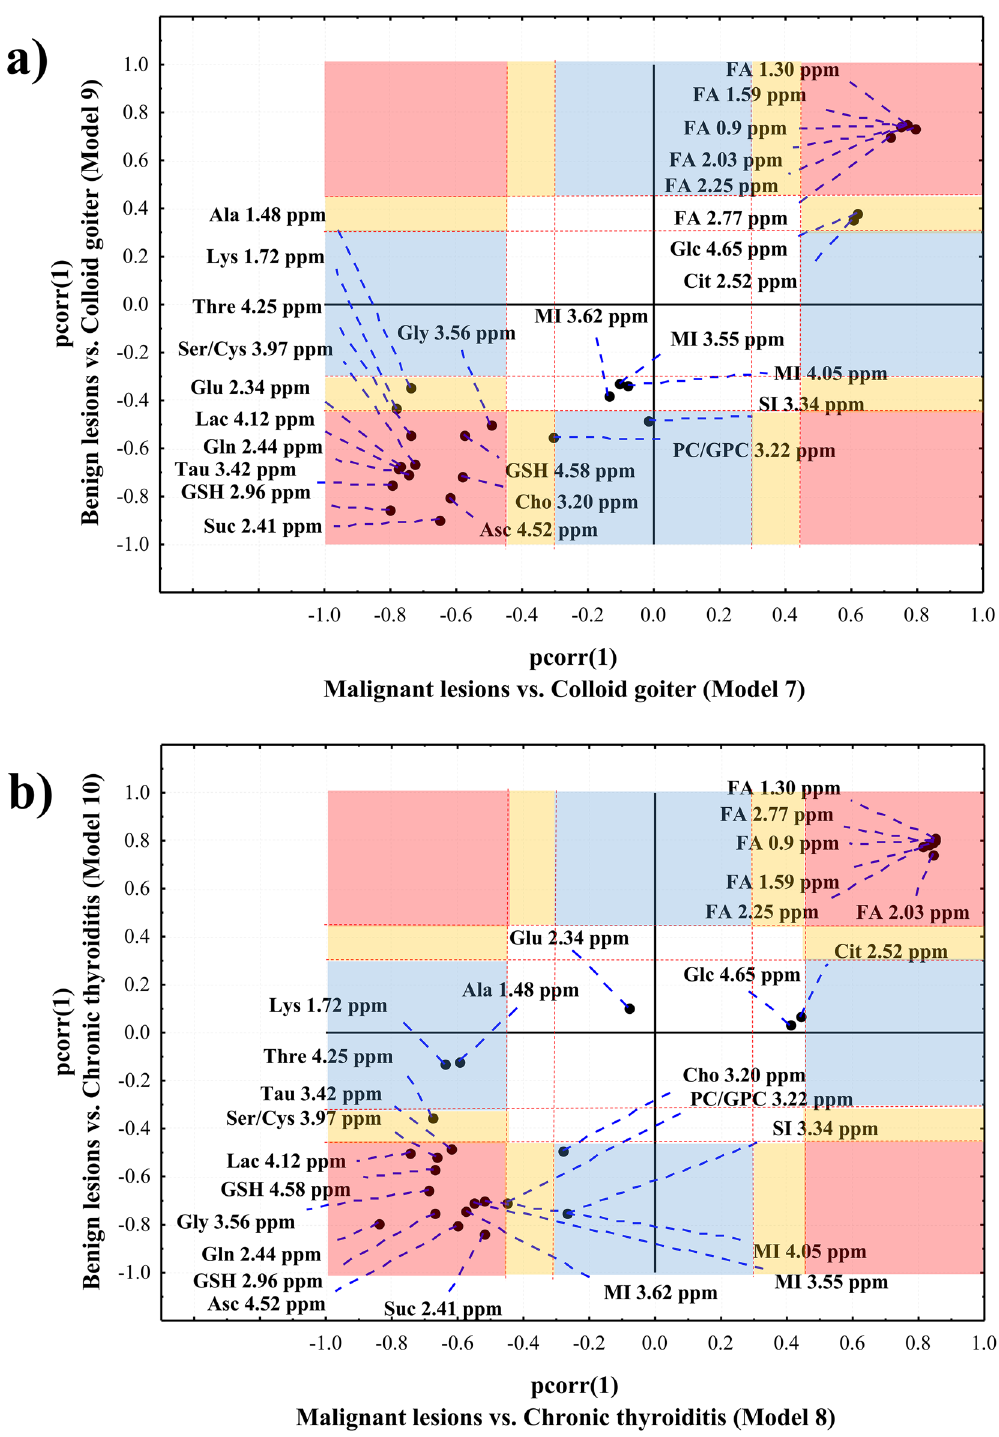
Figure 6. A Shared and Unique Structures (SUS) analysis – a SUS-plot comparing the OPLS-DA models: ( a ) 7 vs 9 and ( b ) 8 vs 10. pink filled square—section 1, |pcorr(1)| > 0.45 in both models, blue filled square—section 2, |pcorr(1)| > 0.45 in one model and 0 < |pcorr(1)| < 0.3 in the other model and yellow filled square—section 3, |pcorr(1)| values > 0.45 in one model and 0.3 < |pcorr(1)| < 0.45 in the other model. Red open square denotes the area where the metabolites do not contribute to the models. The dashed red lines mark the limits of the sections. The metabolites located along the diagonals represent the shared features while the off-diagonal metabolites represent the unique features. The image was created using SIMCA-P 15.0 software package (Umetrics AB, Umeå, Sweden). https ://www.sarto